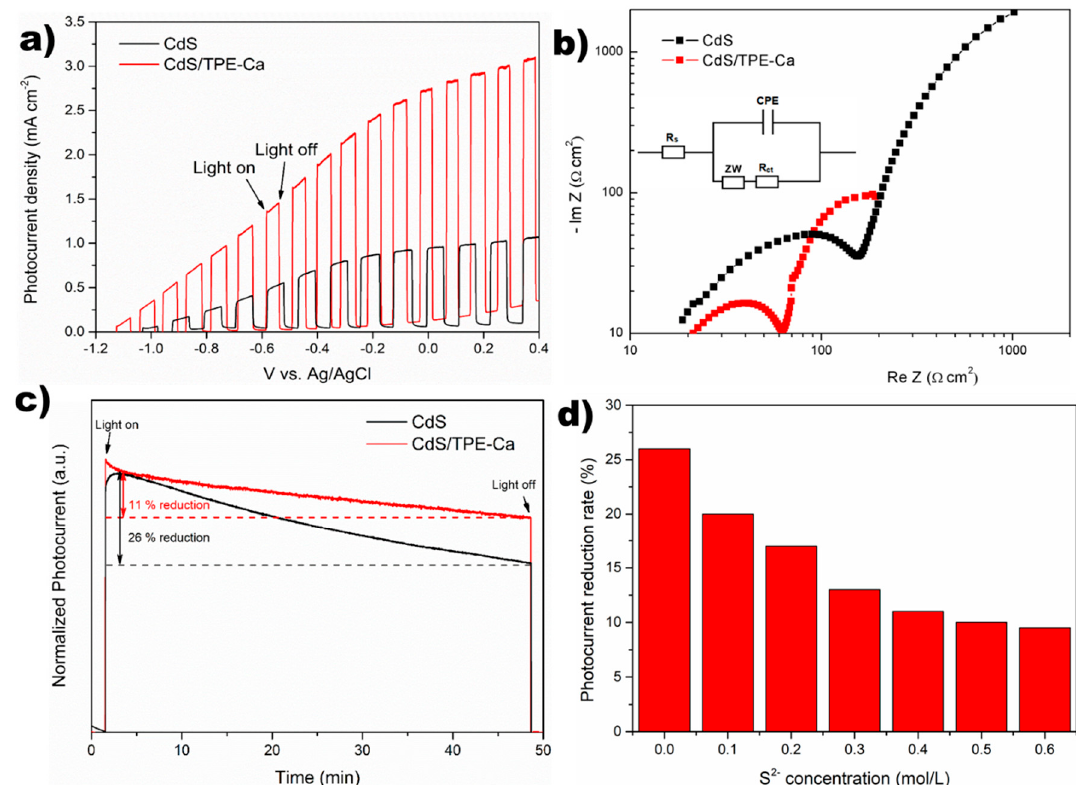
Figure 3. ( a ) Linear sweep voltammogram with chopped illumination every 10 s and ( b ) electrochemical impedance spectroscopy (EIS) Nyquist plots of CdS and CdS/TPE-Ca electrodes under illumination, respectively; ( c ) the photostability test of CdS and CdS/TPE-Ca in NaOH/Na 2 SO 3 (pH 13) electrolyte, the photocurrent density of photoelectrodes were normalized for convenient comparison; ( d ) the photocurrent reduction rate of CdS after 50 min illumination when using different concentration of Na 2 S sacrificial reagent.